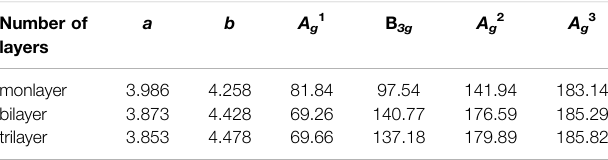
TABLE 3 | The lattice constant and activate Raman frequency (in the unit of Å and cm − 1 ) for monolayer, bilayer and trilayer GeSe. Number of layers